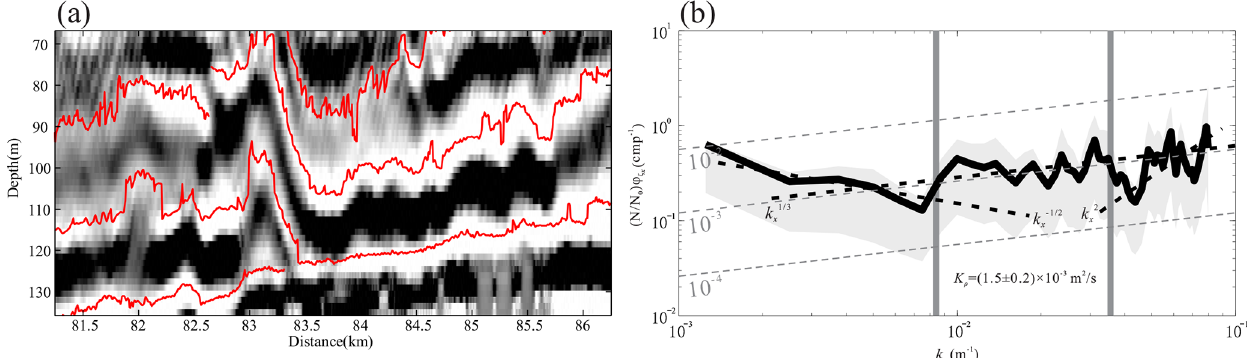
Figure 3. (a) The reflection seismic events in a grid. (b) The average horizontal slope spectrum (black line). The gray shadow represents the 95% confidence interval. The gray dashed lines represent the diffusivity contour. The black dashed lines represent the spectral slopes in the internal wave subrange, turbulence subrange and noise subrange, respectively. The gray vertical lines indicate the boundaries of the turbulence